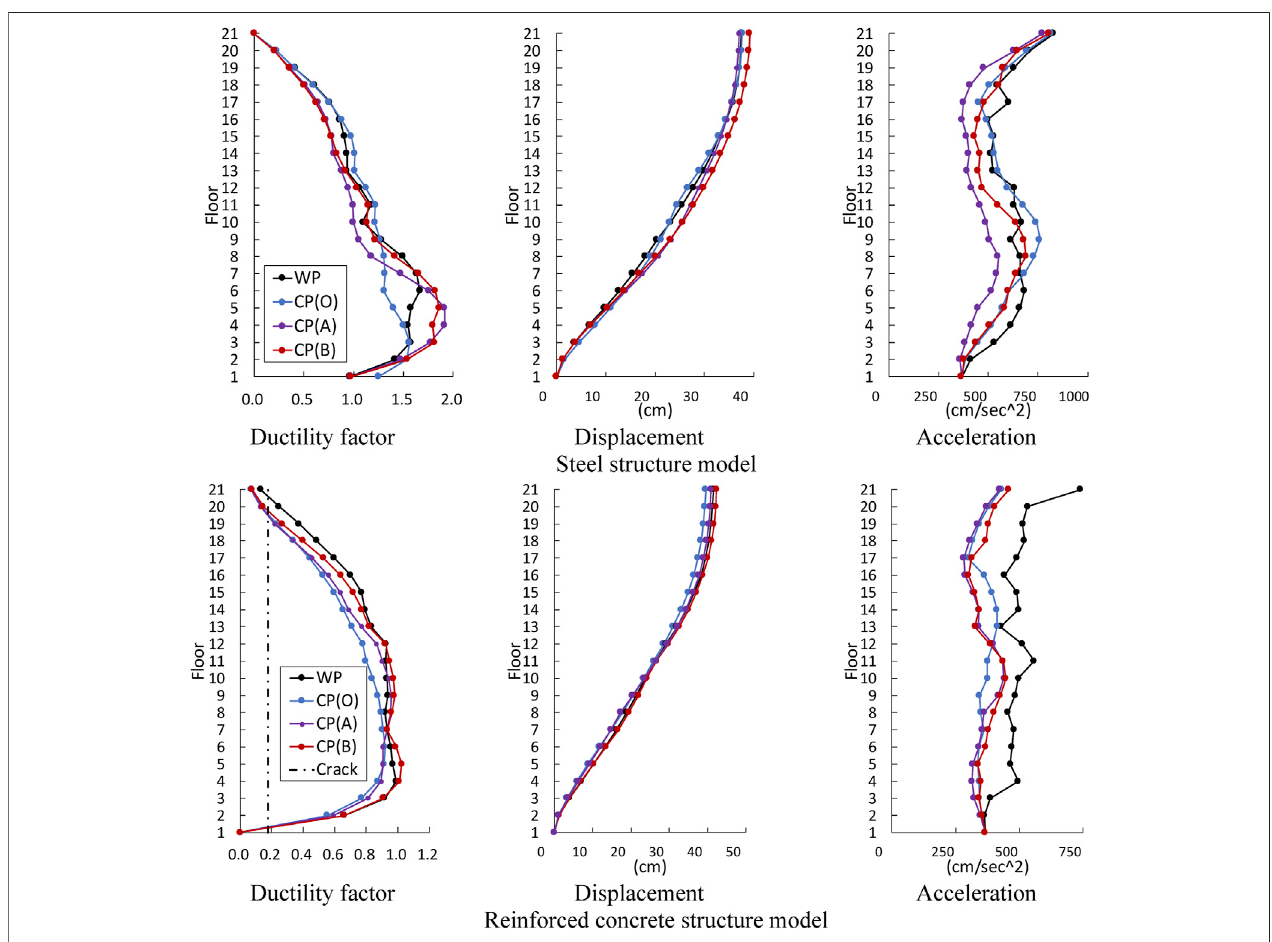
FIGURE 10 | Maximum response of inelastic